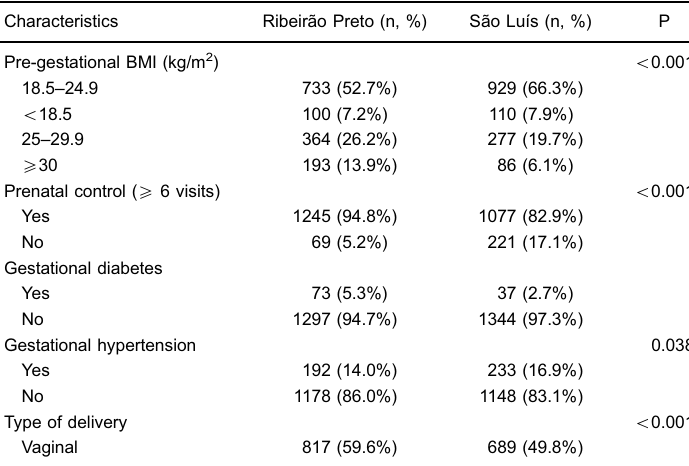
Table 2. Reproductive and obstetric characteristics. Comparison between the Ribeirão Preto and São Luís 2010 birth cohorts. Characteristics